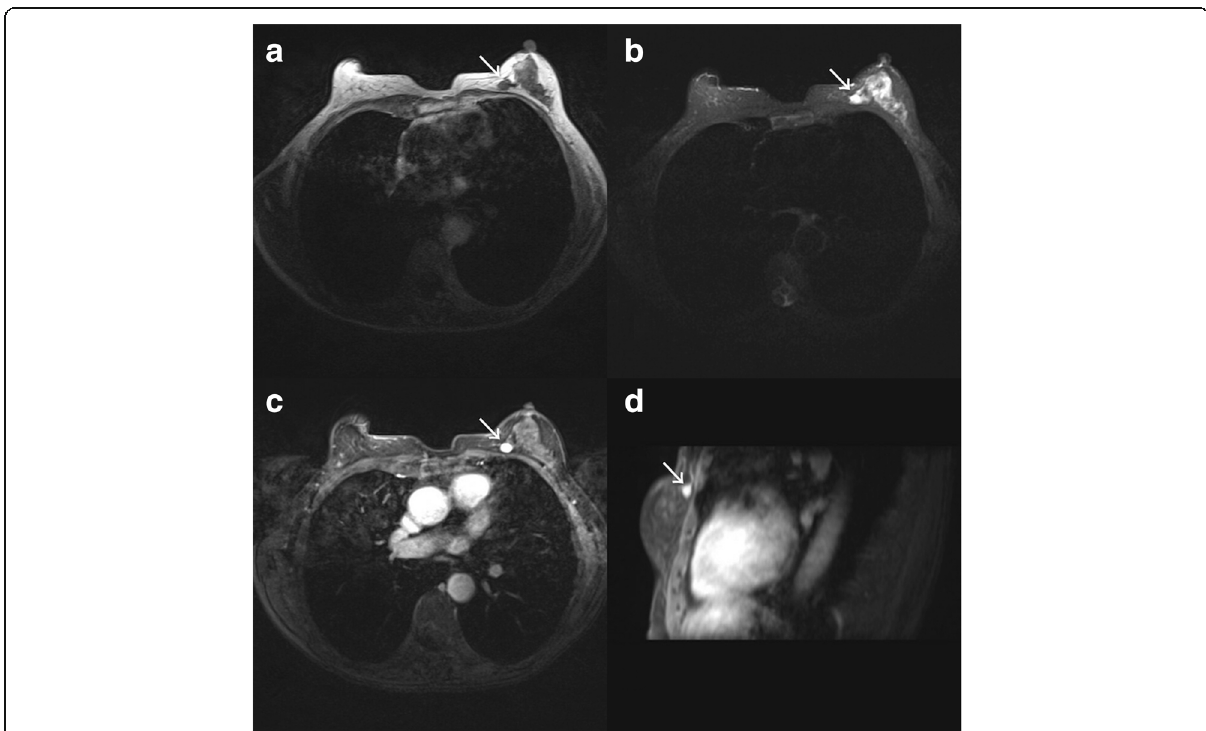
Fig. 2 Breast MRI. Rounded lesion in the left breast was adjacent to the chest wall, hypo-intense on a T1-weighted image ( a ), hyperintense on a fat-saturated T2-weighted image ( b ) and was significantly enhanced following gadolinium administration ( c and d